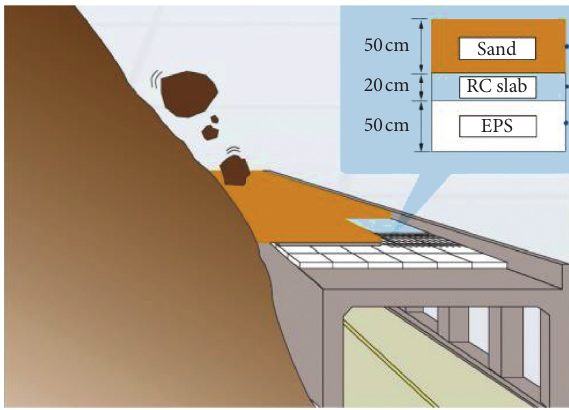
Figure 1: Outline of rock shed and cushioning